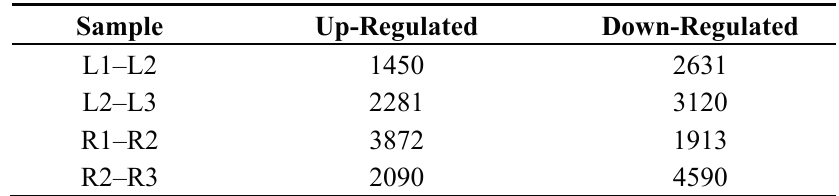
Table 1. Numbers of unigenes that had differential expression patterns during drought stress. The comparisons were conducted from posterior samples to anterior ones. For example, the first row indicates that there were 2631 down-regulated unigenes and 1450 were up-regulated unigenes in sample L2 compared with sample